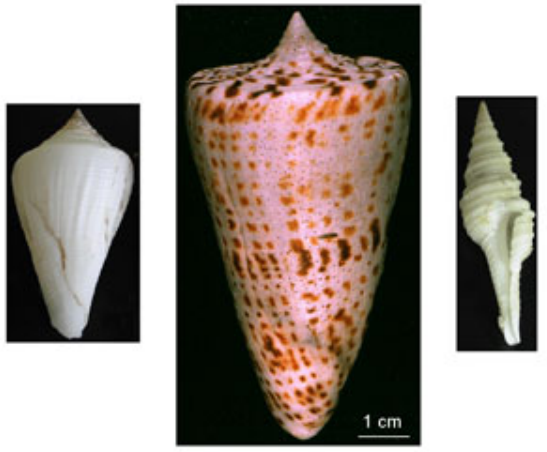
Figure 1. Shells of the three toxoglossate snails studied, left to right: C. austini , C. spurius and P. albida